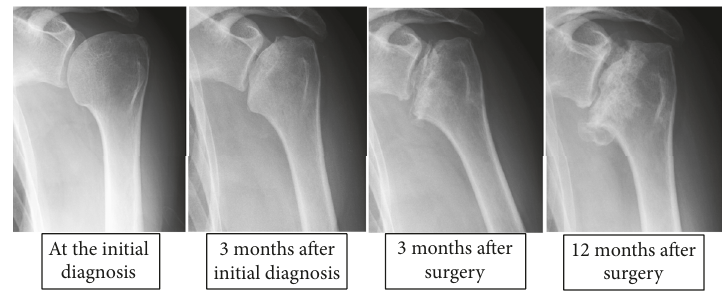
Figure 4: X-ray images of Case 4